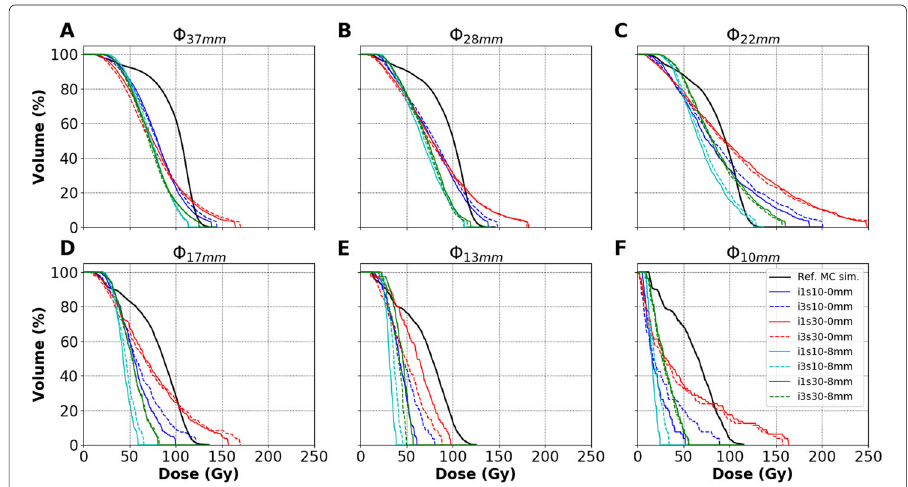
Fig. 3 The DVH VSV pet for 8 different reconstructions are compared to the DVH MC of Ph3. Sphere sizes are represented in A 37 mm, B 28 mm, C 22 mm, D 17 mm, E 13 mm and F 10 mm. The dose-axis and volume-axis in each figure have the same corresponding limits